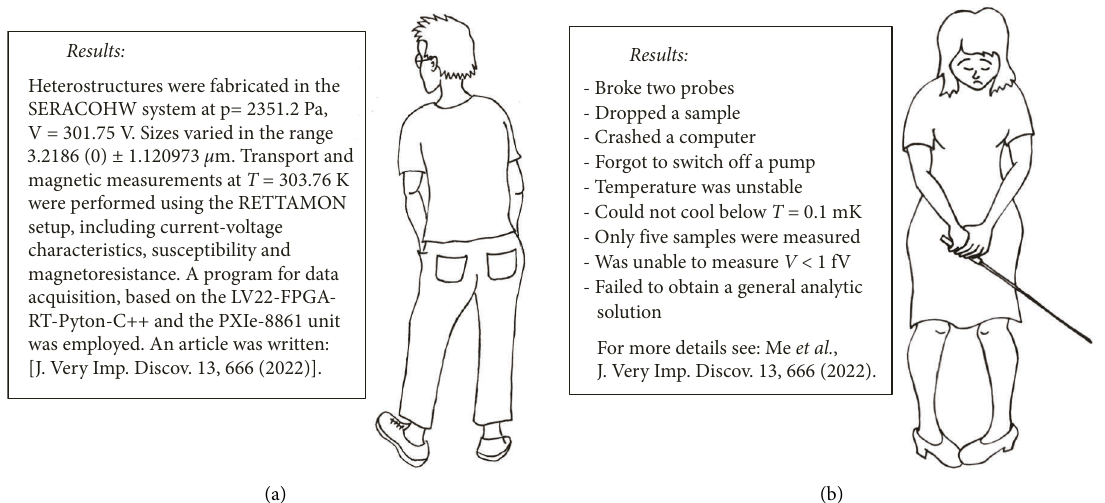
Figure 1: Typical mistakes made by students: extreme technicality (a) and extreme negativity